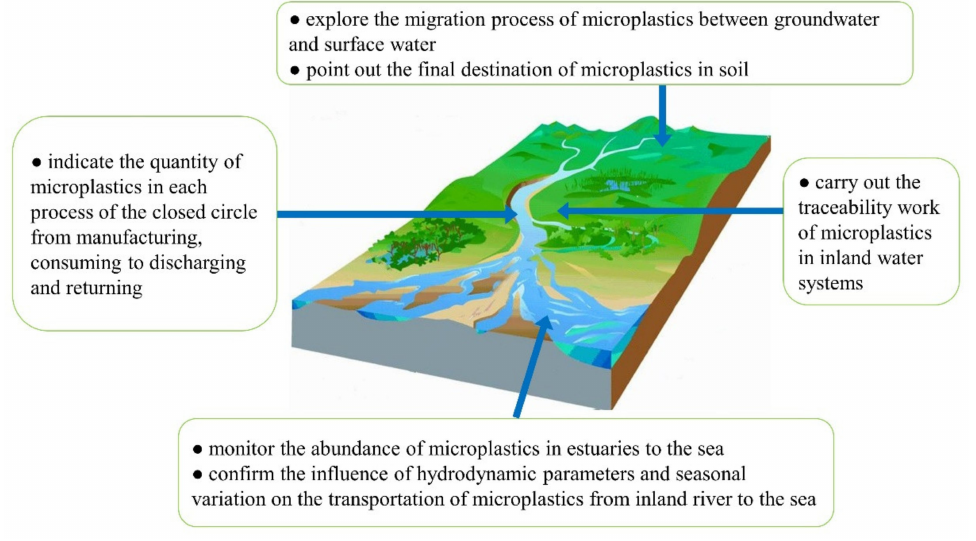
Figure 5. Suggestions for microplastics study in inland water